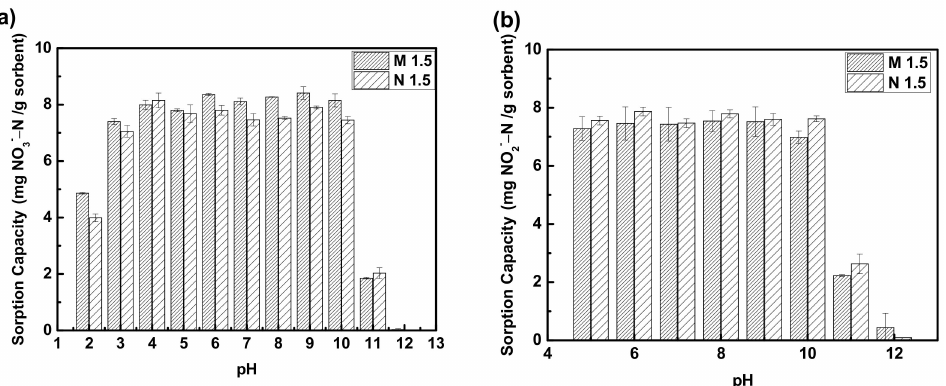
Figure 5. pH Effect (pH 2 to 12) for ( a ) nitrate and ( b ) nitrite adsorption using M 1.5 and N 1.5. Initial concentration of nitrate and nitrite were 50 mg N/L, adsorbent dose of 4 g/L at room